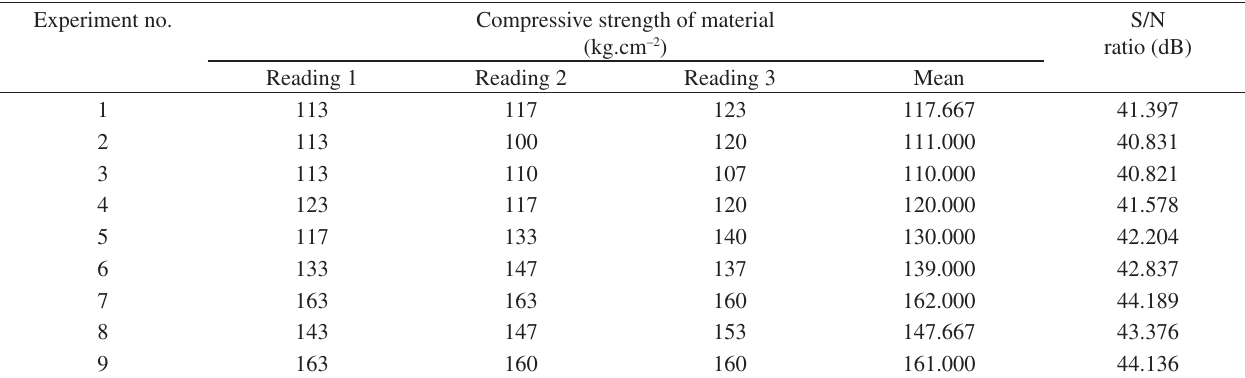
Table 5. Results for quality characteristic and signal-to-noise ratio. Experiment